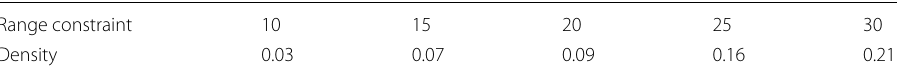
Table 1 The density of the cost matrix Range